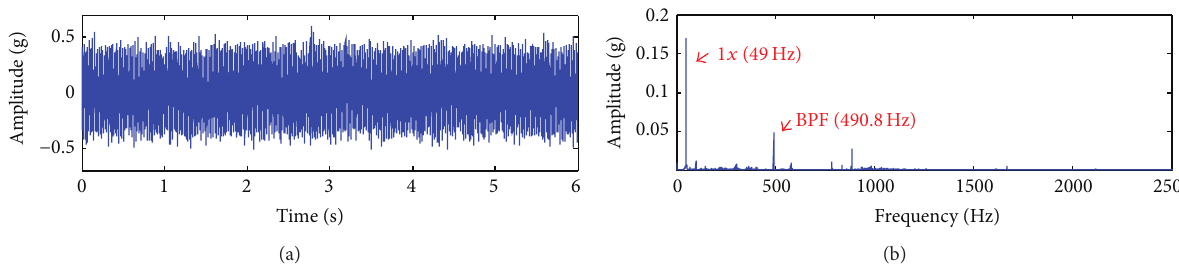
Figure 8: Original vibration signals under 32 mm crack condition: (a) time-domain waveform and (b) frequency spectrum.